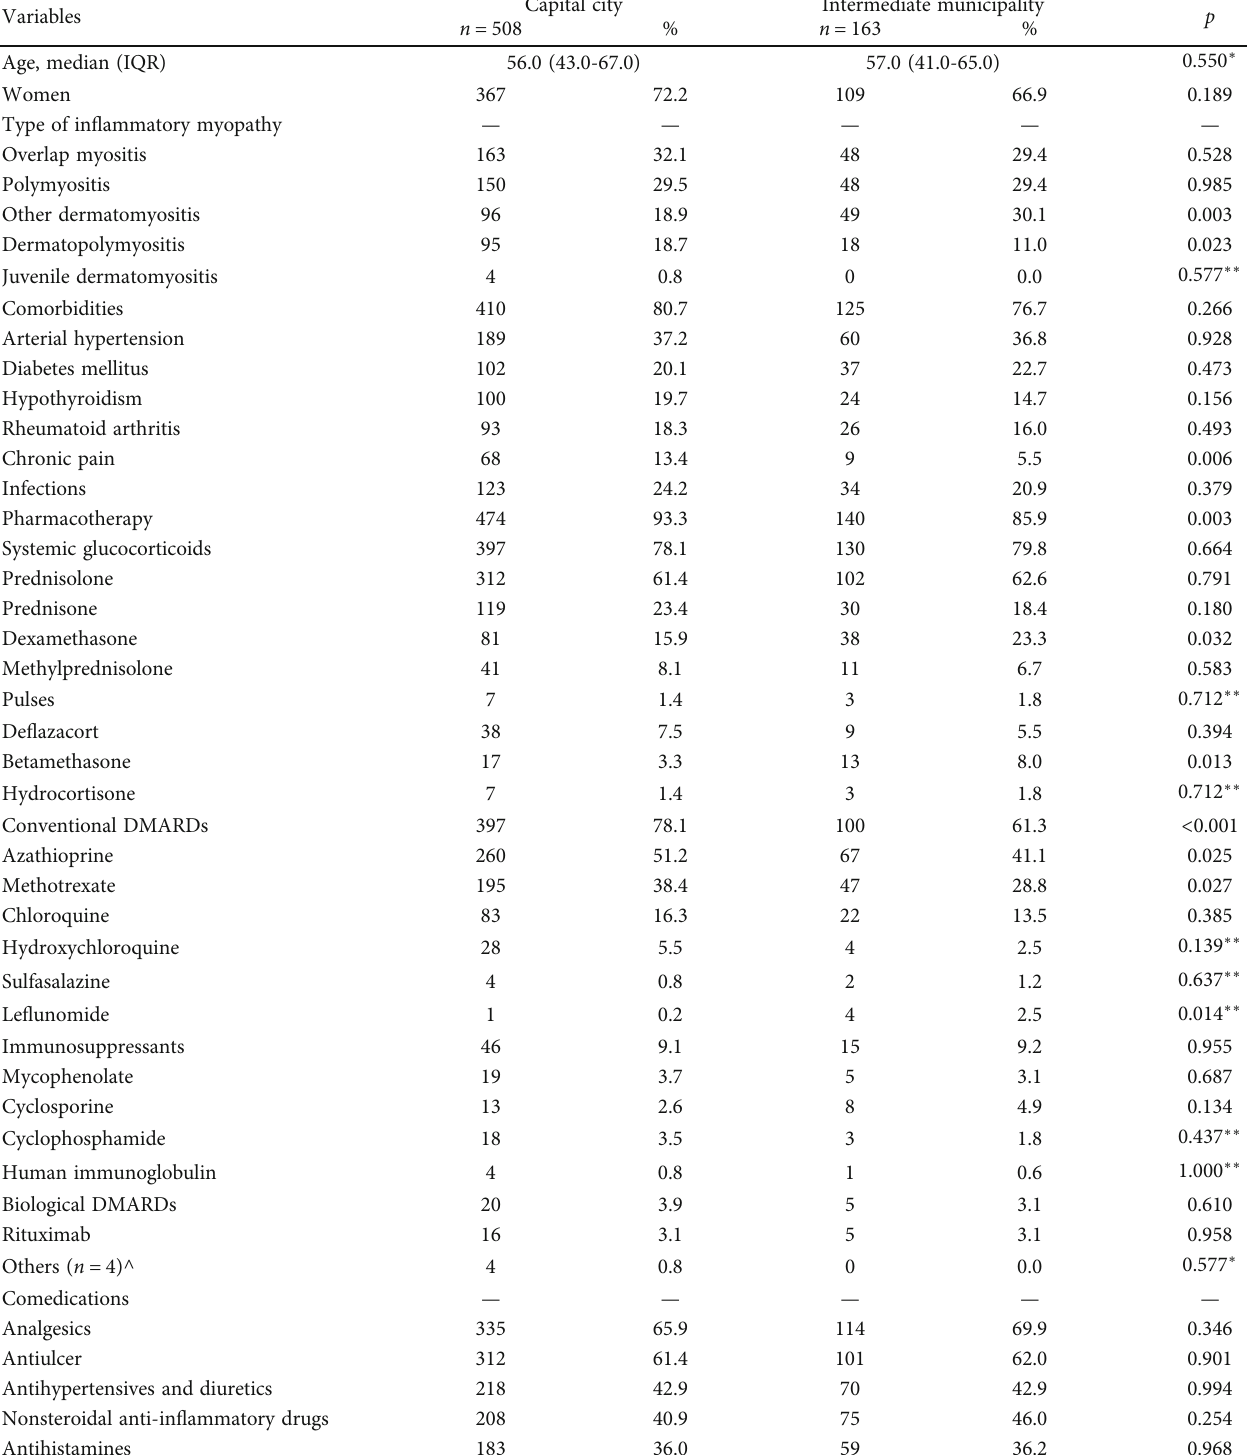
Table 4: Comparison of some sociodemographic and pharmacological variables between cities and municipalities of patients diagnosed with autoimmune idiopathic in fl ammatory myopathies in